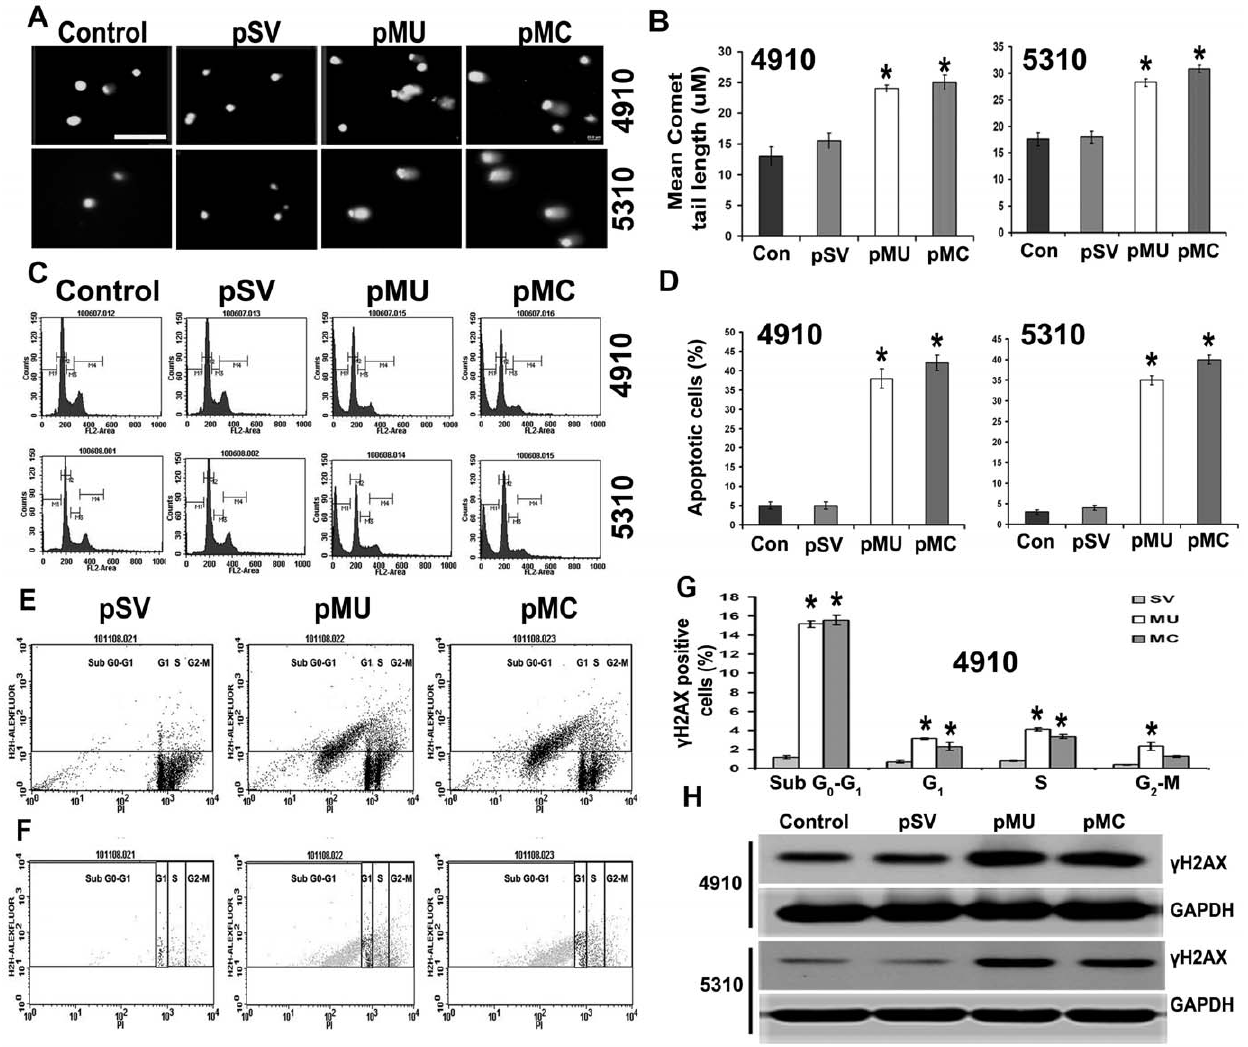
Figure 4. Accumulation of double strand breaks in MU and MC knockdown 4910 and 5310 human glioma xenograft cells. A. Comet assay showing representative comet tail length observed in pMU and pMC transfected 4910 and 5310 glioma xenograft cells along with control and pSV samples. Magnification 40 6 , Bar=20 m m. B. Representative bar graph showing comet tail length in pMU- and pMC-treated 4910 and 5310 glioma cells. Error bars indicate 6 SD. * significant at p , 0.05 Vs control. C. FACS analysis shows cell cycle distribution in pMU- and pMC-treated 4910 and 5310 glioma xenograft cells D. Bar graph shows representative percentage of apoptotic cells in pMU- and pMC-treated verses untreated glioma cells. Error bars indicate 6 SD. * significant at p , 0.05 Vs control. E. FACS analysis showing dot plot of gated c H2AX expression and DNA content in different phases of cell cycle in pMU- and pMC-treated 4910 glioma cells. F. After gating c H2AX expression, its expression in sub G 0 -G 1 , G 1 , S and G 2 -M phases was divided and shown in different shades of gray in pMU and pMC transfected cells compared to pSV. G. Bar graph showing number of cells expressing c H2AX in sub G 0 -G 1 , G 1 , S and G 2 -M phase in pMU- and pMC-treated 4910 glioma xenograft cells along with pSV. 10,000 cells were analyzed during each process. Error bars indicate 6 SD. * significant at p , 0.05 Vs control. H. Western blot analysis of c H2AX shows expression